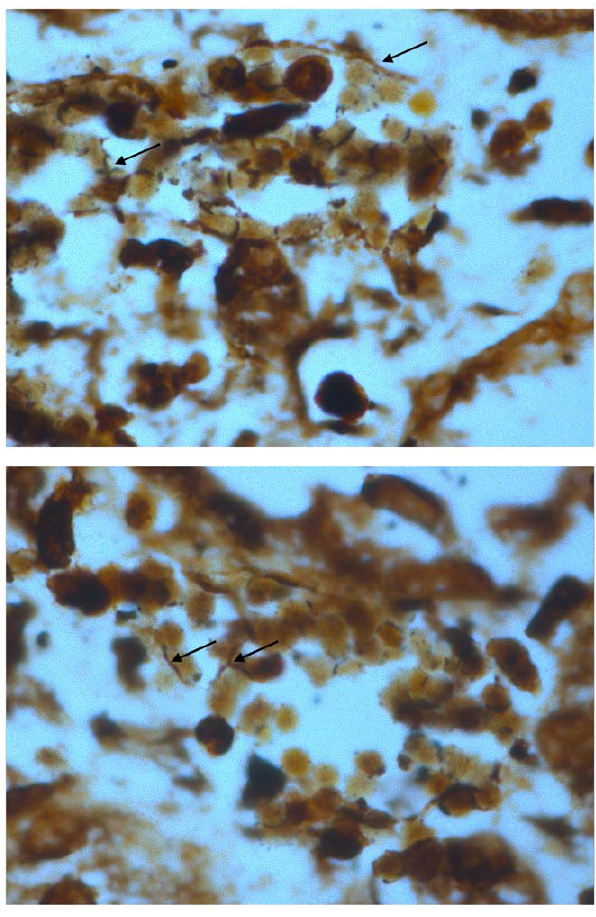
Figure 3. Warthin Starry stain showing Leptospira in the tubular cells of the